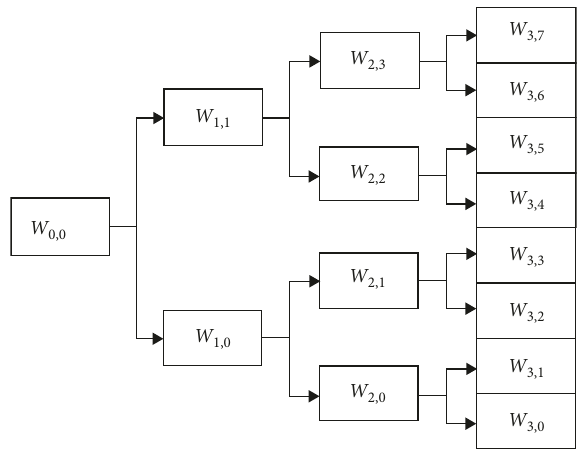
Figure 1: Three-layer